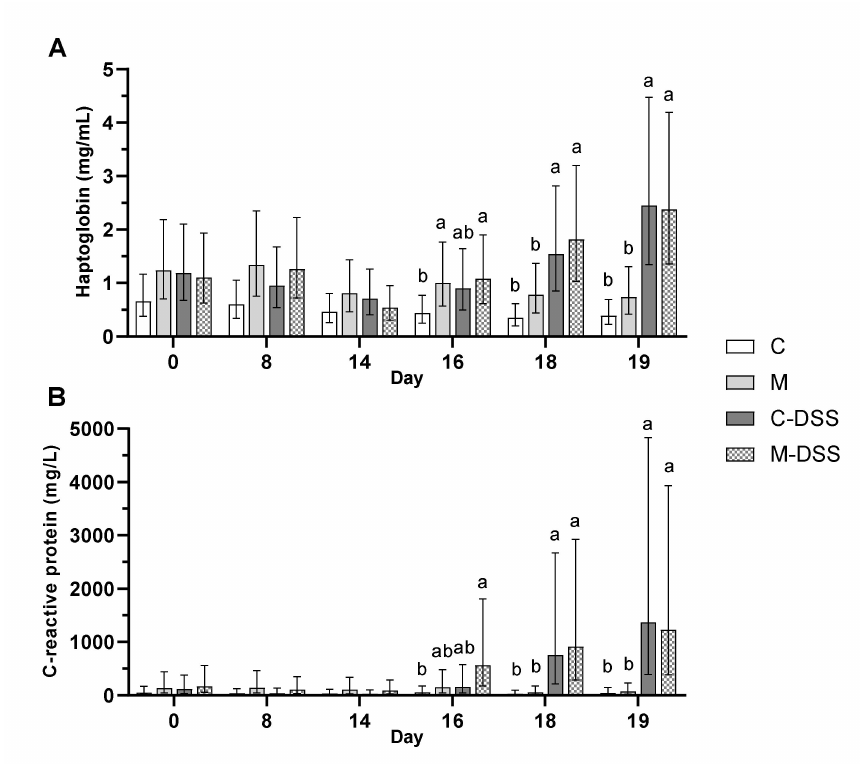
Figure 5. Haptoglobin ( A ) and C-reactive protein (CRP; B ) in plasma of pigs receiving the four di ff erent treatments from day 14 to 18 ( n = 6 / group, except C-DSS n = 5). Data are presented as LS means ± 95% confidence intervals due to logarithmic transformation of data. Di ff erent letters indicate a significant e ff ect of treatment within day ( p ≤